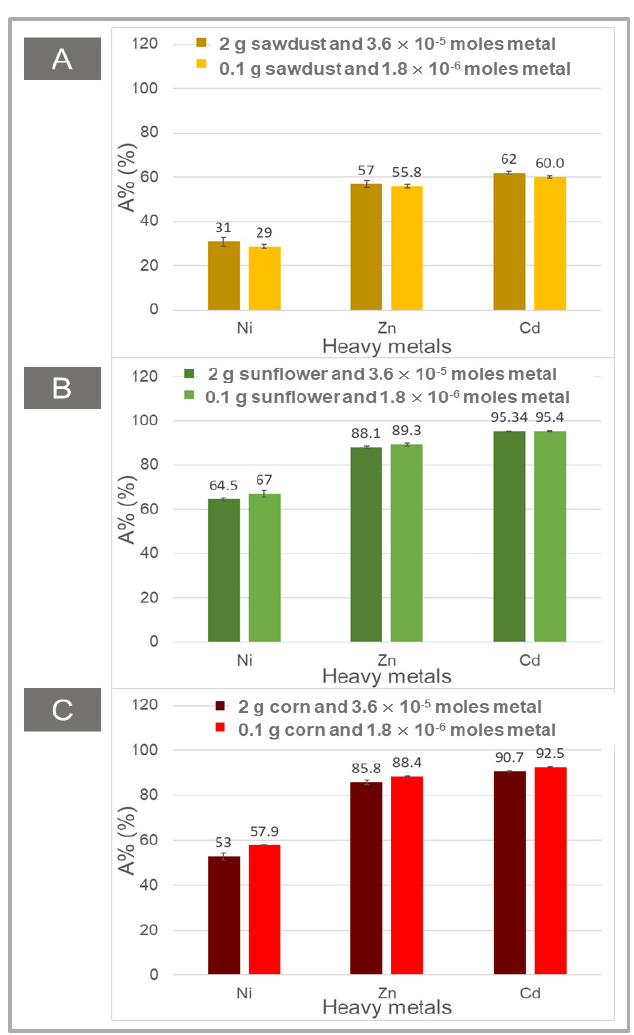
Figure 11. Comparison of the percentage of adsorption (A%) when increasing 20 times the mass of adsorbent and moles of adsorbate in the multi-metal system of heavy metals for: ( A ) pine sawdust, ( B ) sunflower seed hulls, ( C ) corn residues mix.